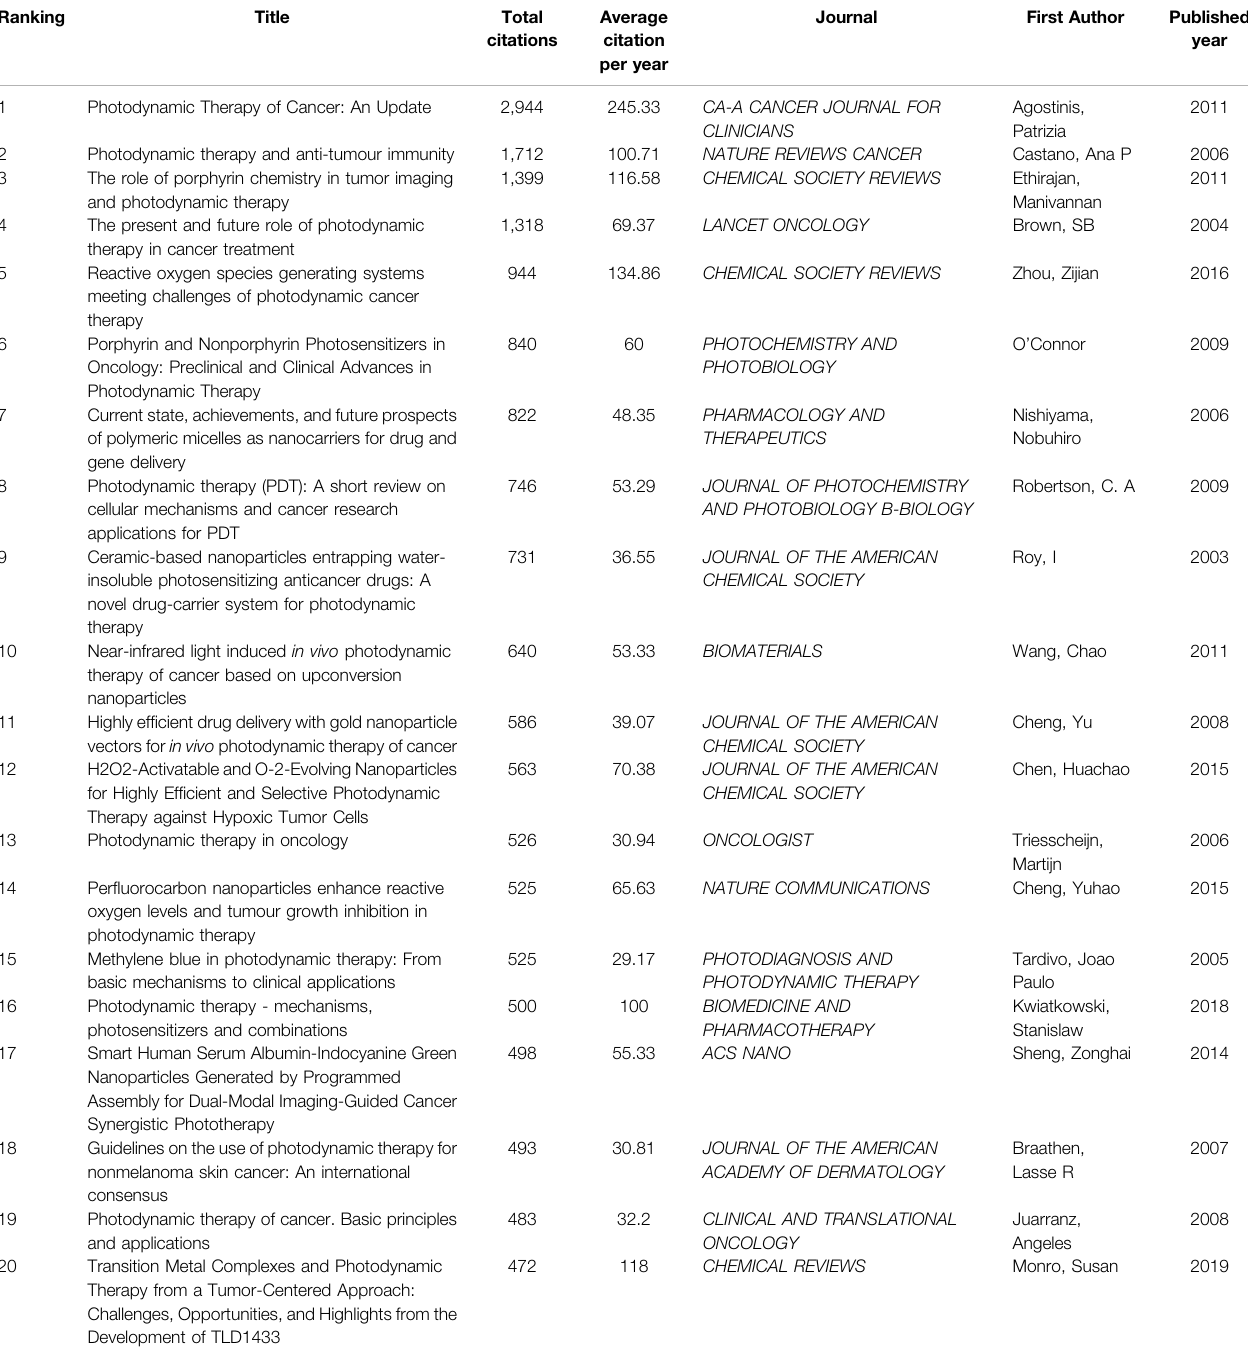
TABLE 3 | Top 20 highly cited publications in CPDT fi